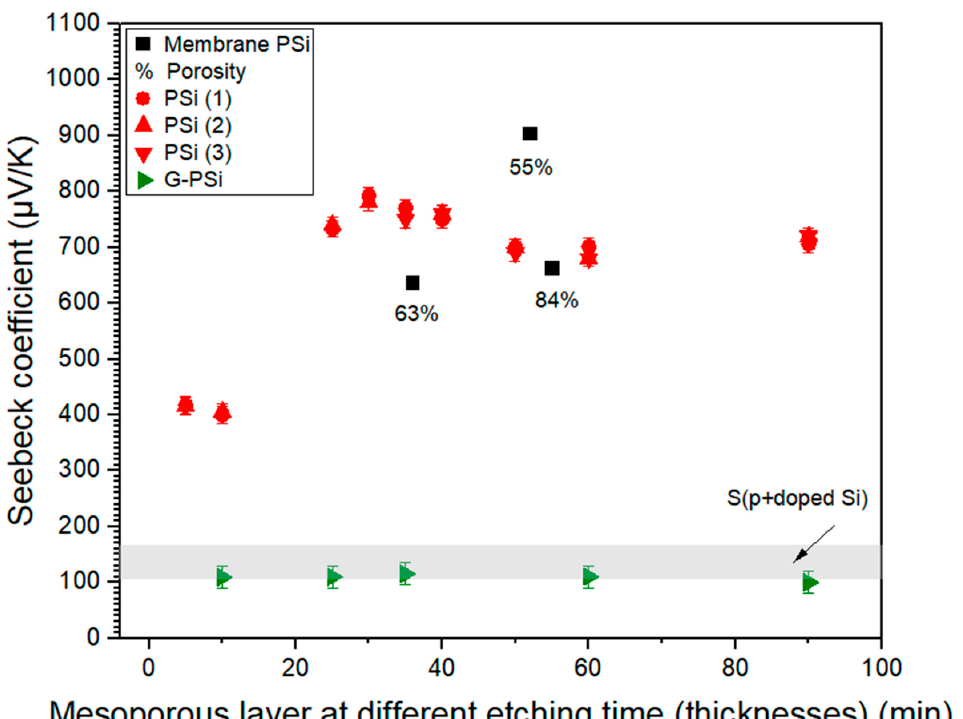
Figure 10. Seebeck coefficient of p + doped Si (our work and [16-18]), Psi, and G-PSi at T = 343 K. By increasing the electrochemical etching time, the thickness of the mesoporous layer was increased with a fixed current density of 100 mA/cm², which has a weak impact on the porosity. On the other hand, the values of the membrane PSi and porosity [27] were obtained at different etching times and current density, which explains the large variation in porosity.